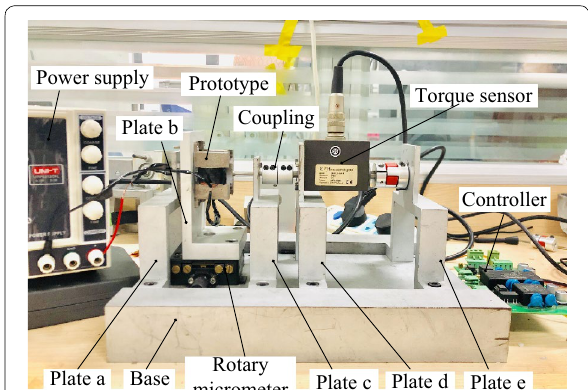
Figure 14 Test rig of torque–angle characteristics